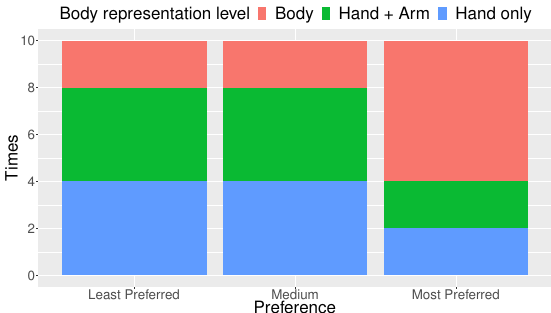
Figure 8. Preference of the three types of